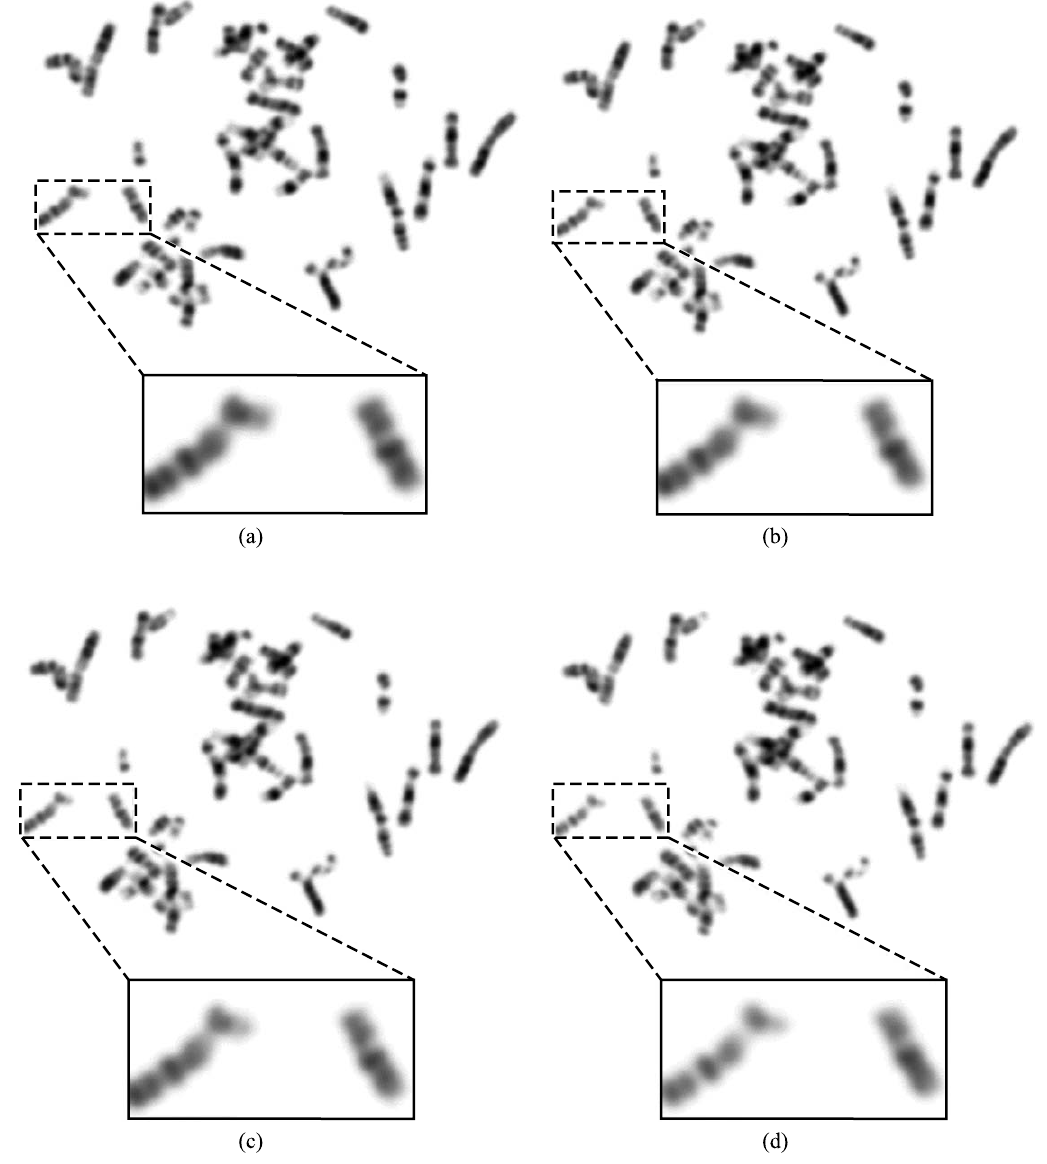
Fig.12. Microscopicimagesfromthesamesampleacquiredunderthe40 × objectiveattheposition1 (cid:2) mbelowthefocalplane;thecorresponding value s are: (a) s =0.6 (b) s =0.8 (c) s =1.0 (d) s